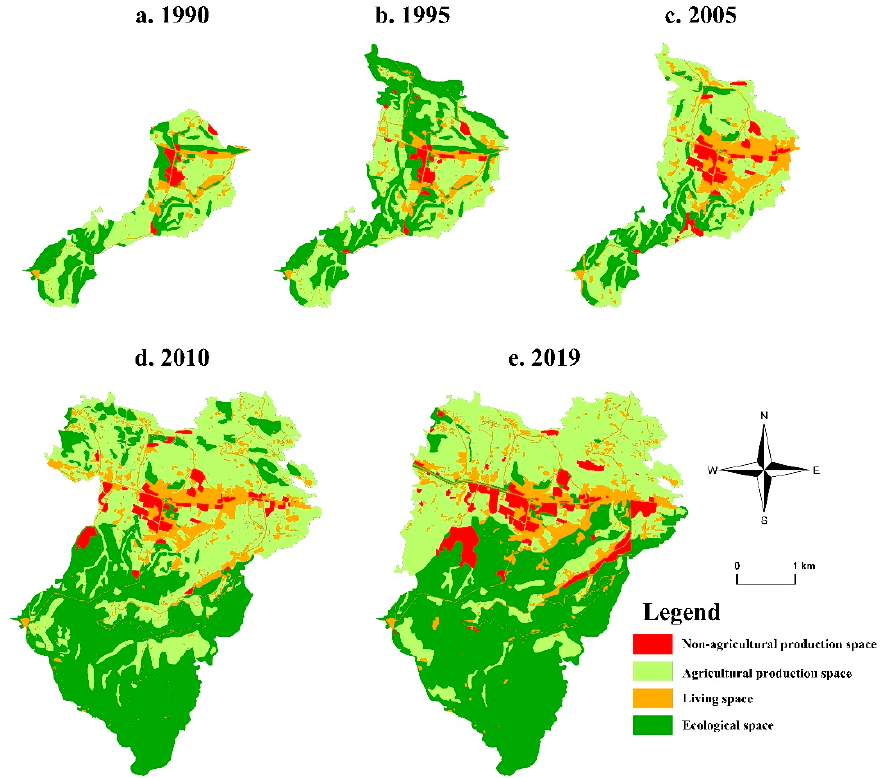
Figure 4. Spatial distribution of Zhulin’s EPL spaces, 1990–2019. Reference system GCS Xian 1980.